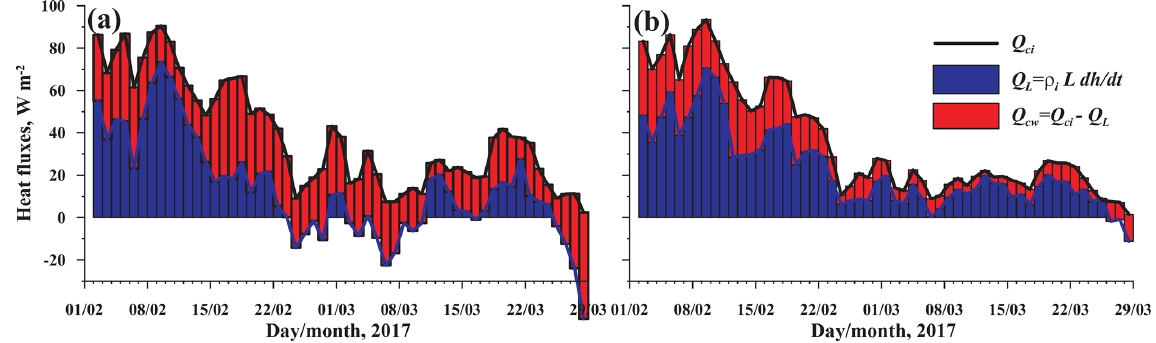
Figure 11. Daily averaged heat balance at (a) station S1 and (b) station S2.